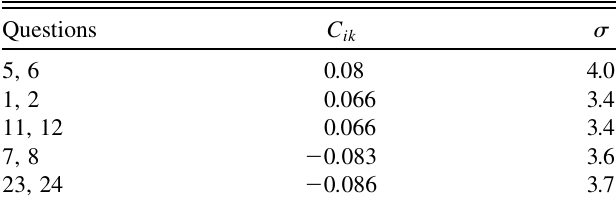
TABLE IV. Item response theory residual correlations C statistically significant at the 3 (cid:3) level, from the post-test data. The rightmost column is how many standard deviations C from the